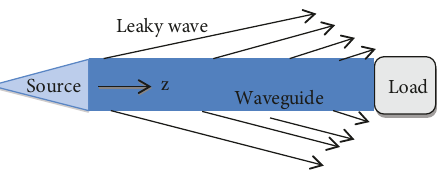
Figure 1: Open dielectric waveguide structure and leaky